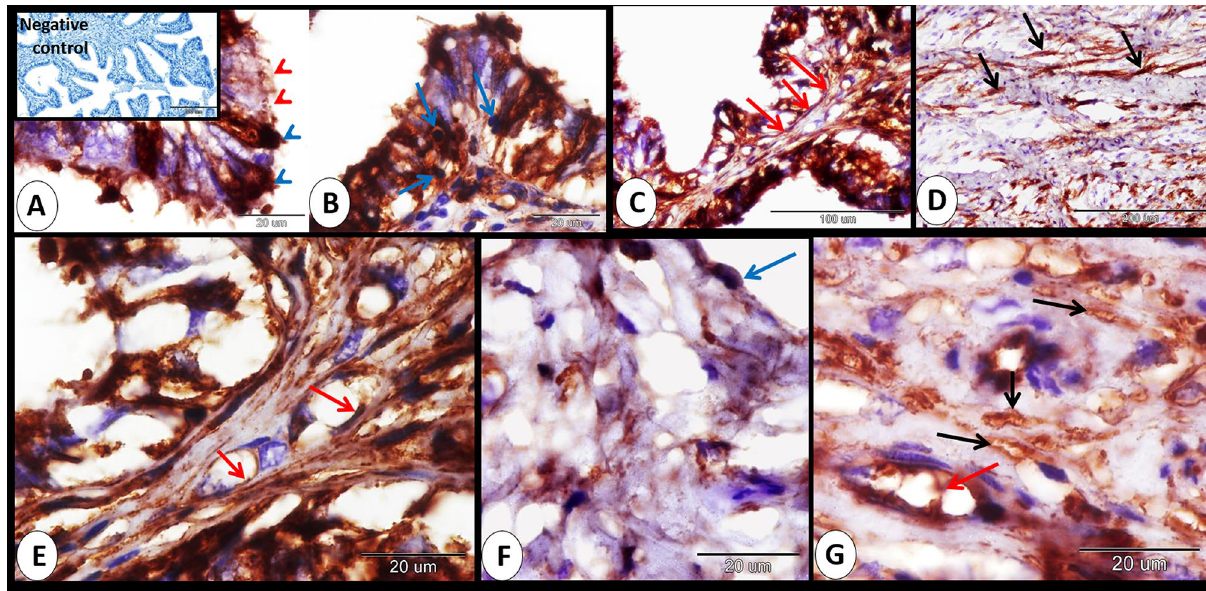
Figure 4. Immunohistochemical localization of ERA in rabbit cervix at 14 days of pregnancy. ( A ) secretory cells (red arrowheads) showed strong cytoplasmic and nuclear immunostaining to ERA and ciliated cells (blue arrowheads) exhibited mild cytoplasmic and nuclear immunostaining to ERA. ( B ) The intraepithelial lymphocytes (blue arrows) showed moderate to strong cytoplasmic and mild to moderate nuclear immunostaining to ERA. ( C ) Telocytes (red arrows) showed strong cytoplasmic and moderate nuclear reactions to ERA. ( D ) smooth muscle fibers (black arrows) demonstrated strong cytoplasmic and nuclear immunoreactivity of ERA. ( E ) the endothelial cells (red arrows) of the blood vessels exhibited moderate ERA immunostaining. ( F ) Serosal mesothelium (blue arrow) showed strong ERA immunostaining. ( G ) blood plasma (red arrow)demonstrated moderate immunoreactivity to ERA and interstitium (black arrows) showed strong immunoreactivity to ERA. Note, bordered area in A the negative